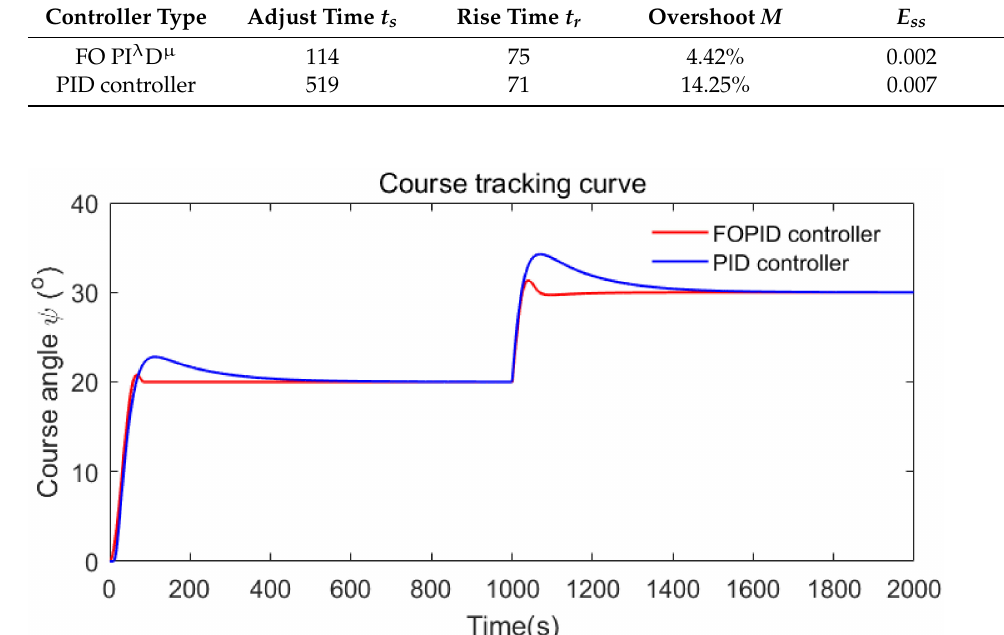
Figure 12. Course-tracking curves with FO PI λ D µ controller and PID controller.